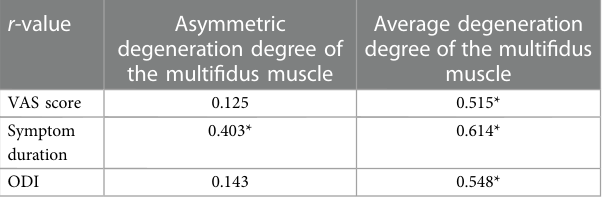
TABLE 5 Correlation between asymmetric and average degeneration degree of the multi fi dus muscle and the VAS score, symptom duration, and ODI.